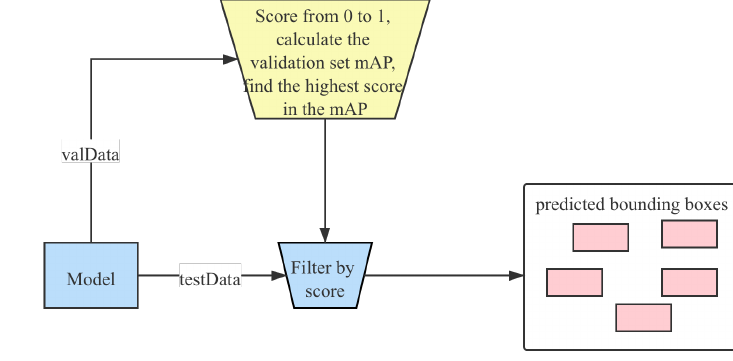
Figure 8. The flow chart of the OoF